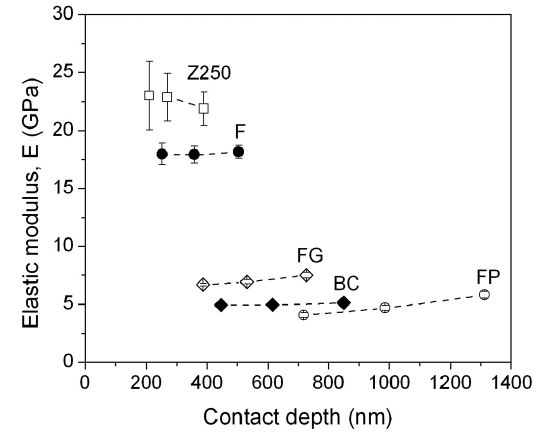
Figure 2. Typical load-displacement curves obtained from the nanoindentation tests for a bare Filtek Z250 ® composite resin (Z250) and the Z250 sample filled with BisCover ® (BC) sealant. The samples were submitted loading-unloading cycles with three normal loads: 1.25, 2.5 and 5.0 mN.